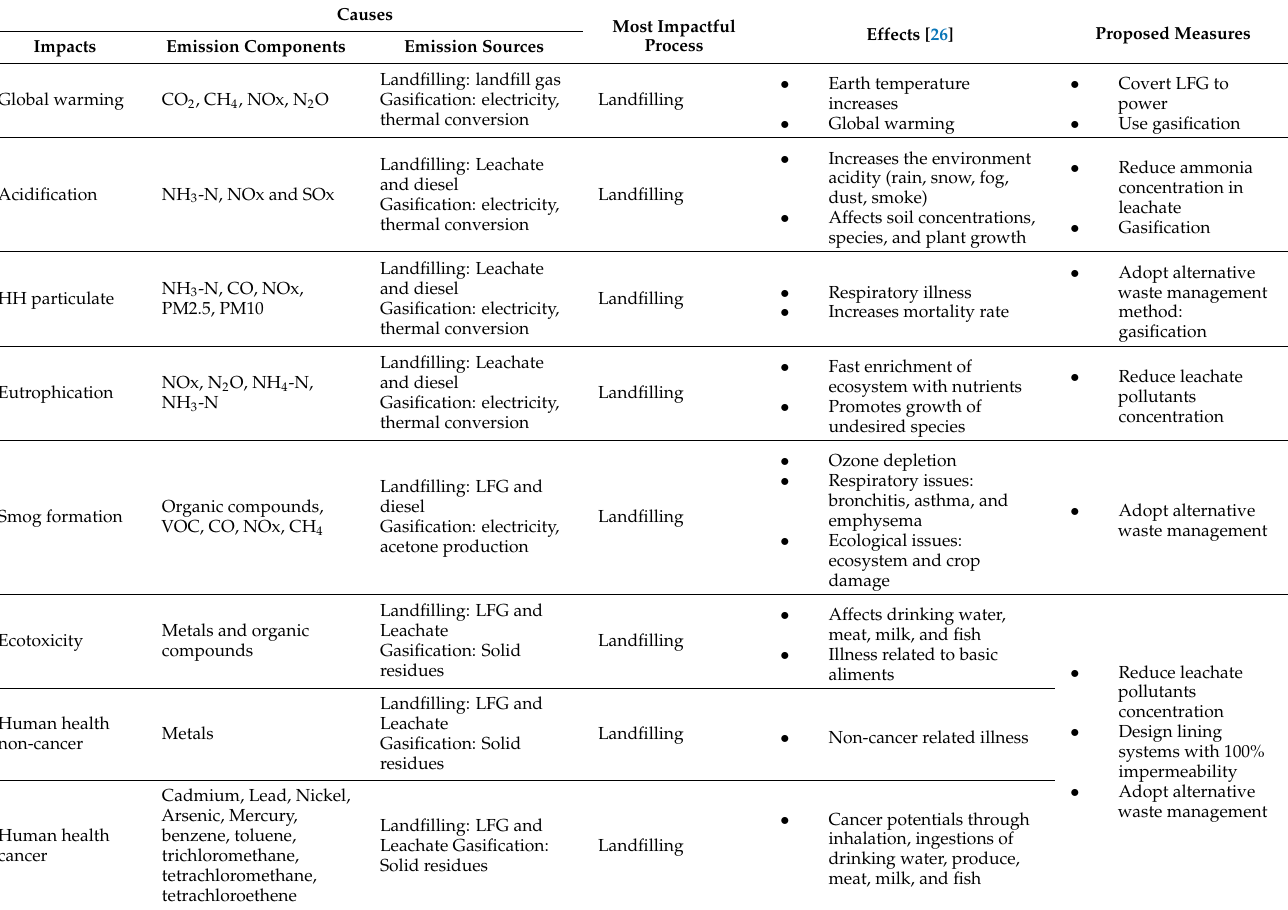
Table 7. Impact assessment causes and proposed